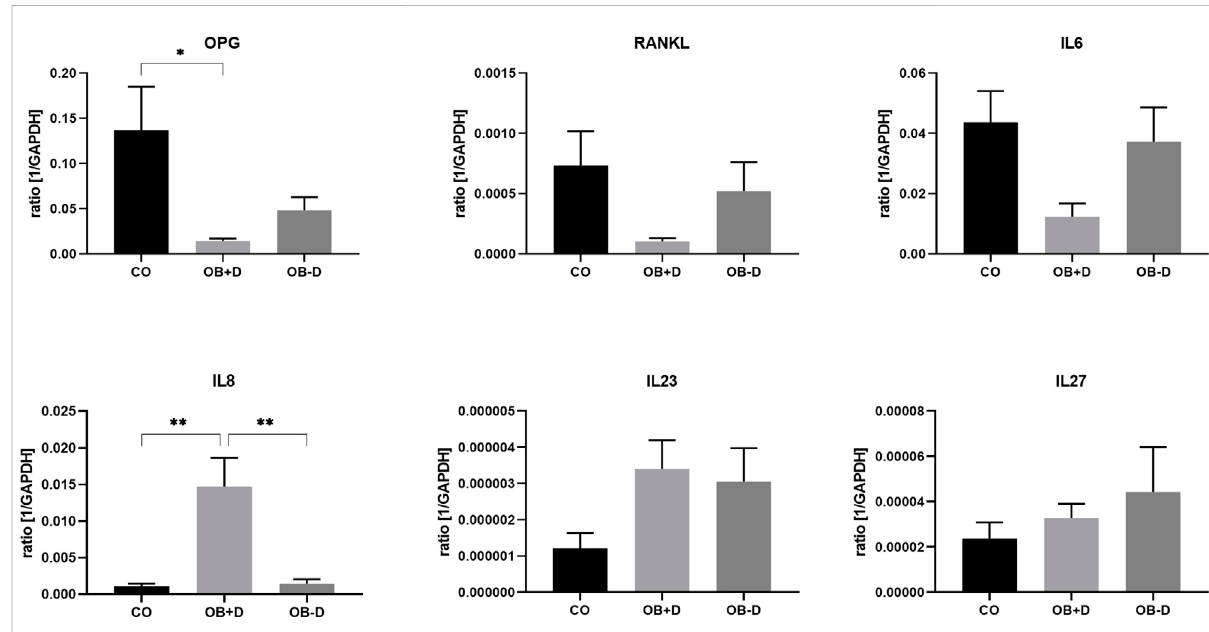
FIGURE 8 Expression of osteoclastogenesis-related genes by JPCs cultured for 15 days with control medium (CO) and osteogenic medium with (OB+D) andwithout(OB − D)dexa.Mean±SEMvaluesofmRNAcopynumbersnormalizedtothehousekeepinggeneGAPDHwerecalculatedandcompared using one-way ANOVA and Tukey ’ s multiple comparison test (n = 7, * = p < 0.05, ** = p <